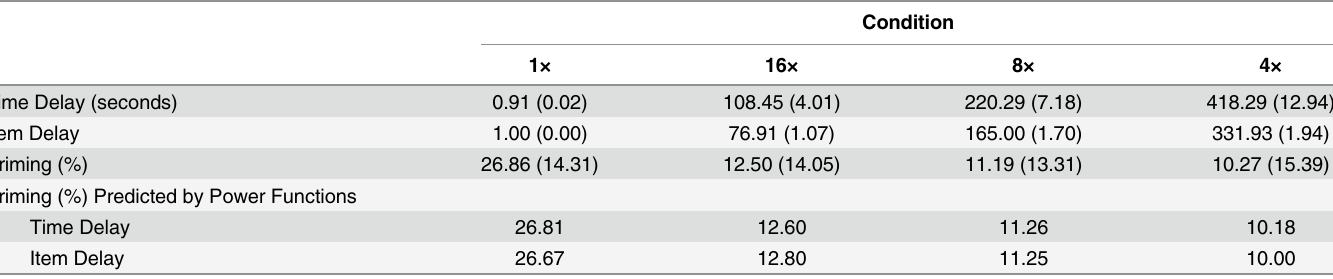
Table 2. Mean Time Delay, Item Delay and Percentage of Priming (with Standard Deviation) within each